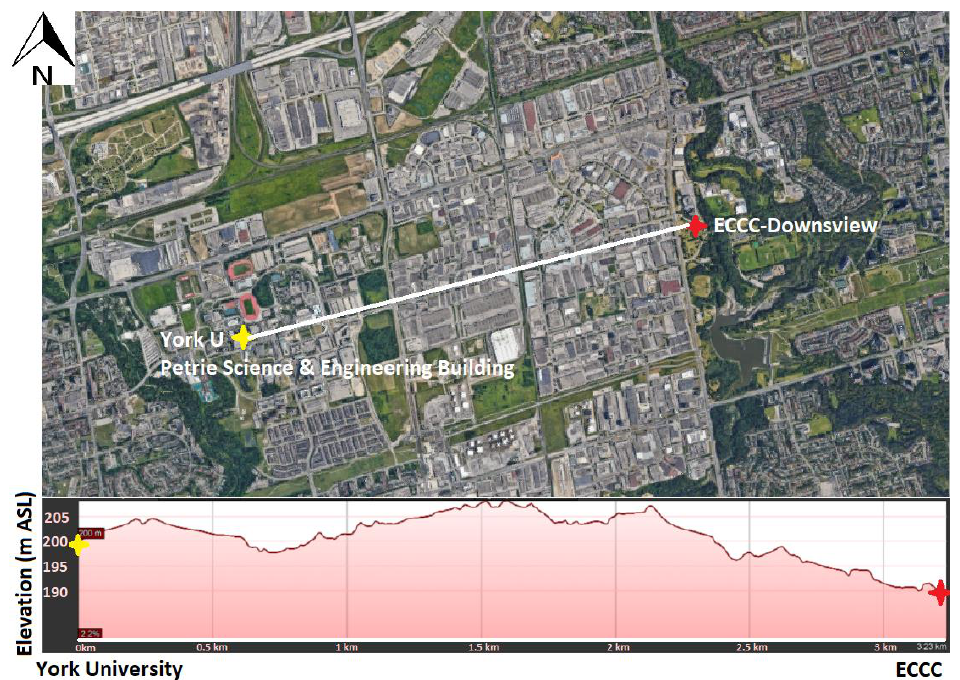
Figure 1 . Map of northwestern Toronto, highlighting the locations of the Raman lidar at York University (yellow cross) and the differential absorption lidar (DIAL) at Environment and Climate Change Canada (ECCC) Downsview (red cross). A cross-sectional topographic map along the transect (white line) between the two lidars is provided in the bottom panel. Image © 2019 Google.